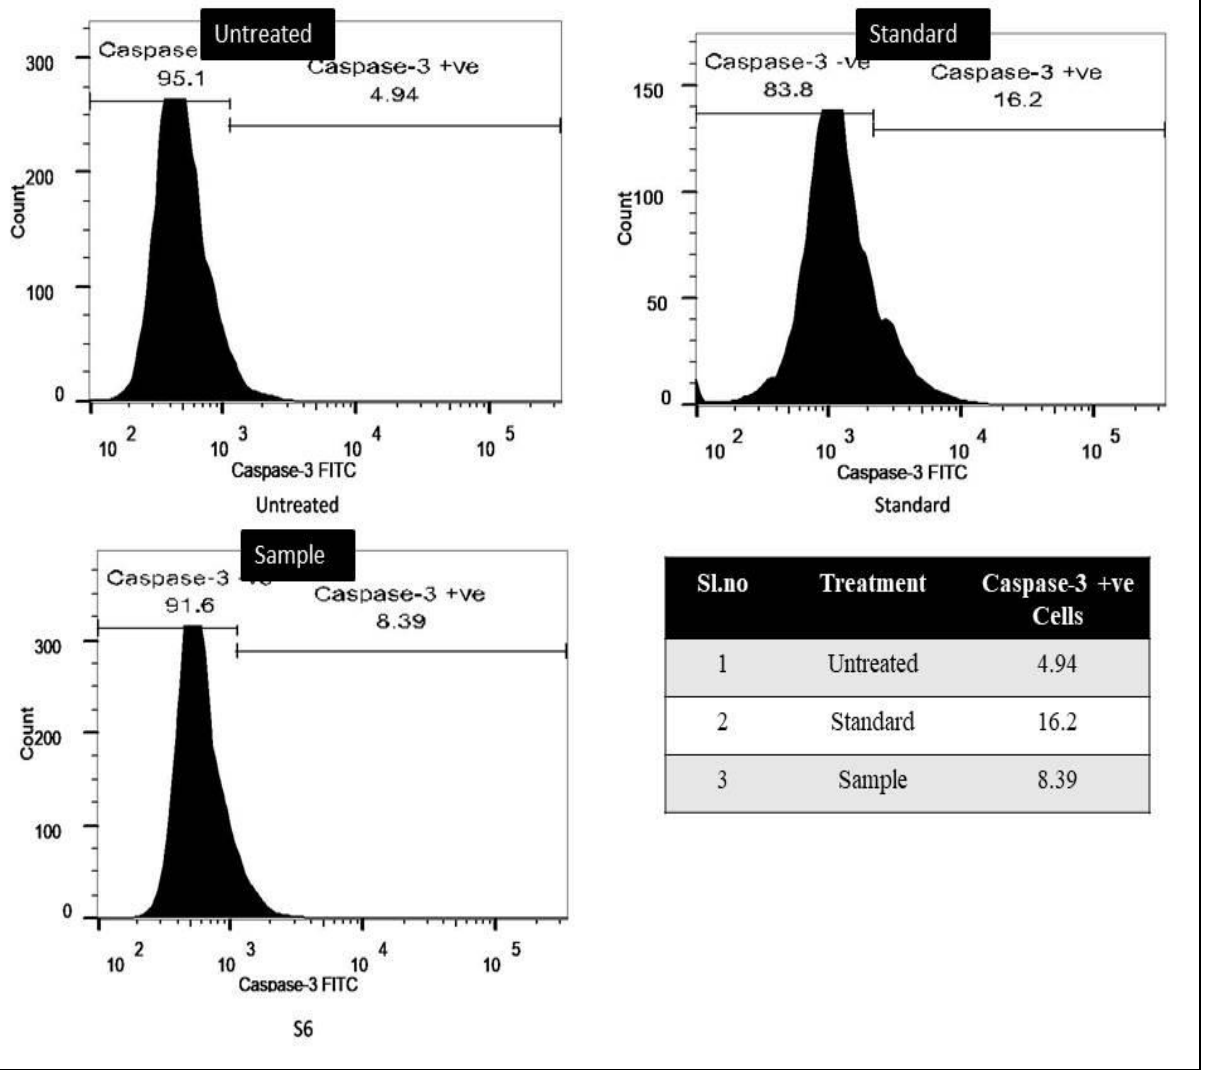
Figure 3. Confirmation of apoptosis induced by methanol extract of C. colocynthis in the lung cancer A549 cell line through caspase-3 assay.